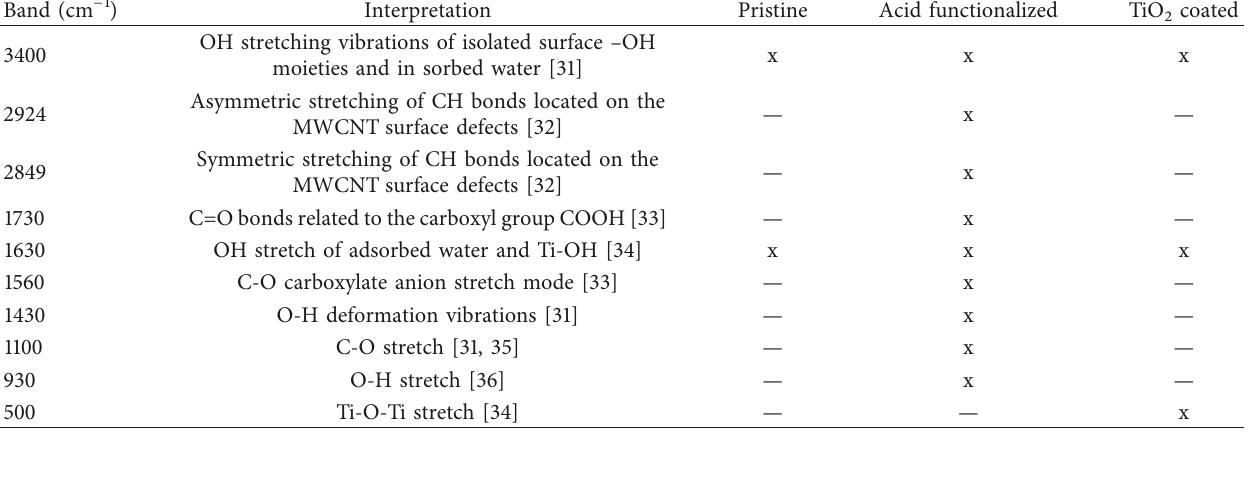
2 -coated MWCNTs.